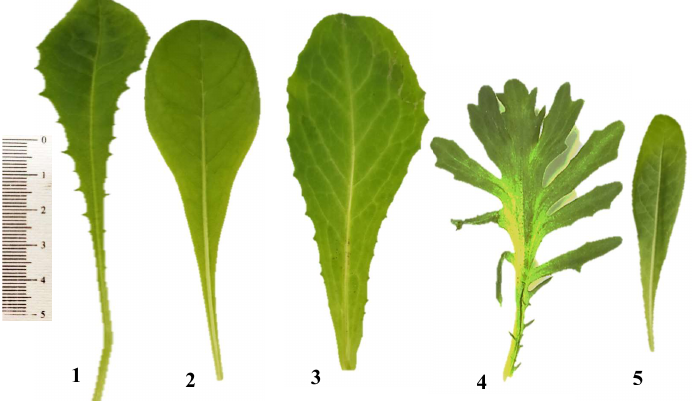
Figure 1. Leaf shapes of Cichorium taxa. 1 : C. intybus var. intybus ; 2 : C. intybus var. foliosum ; 3 : C. endivia var. endivia ; 4 : C. endivia var. crispum ; 5 : C. endivia subsp. pumilum .